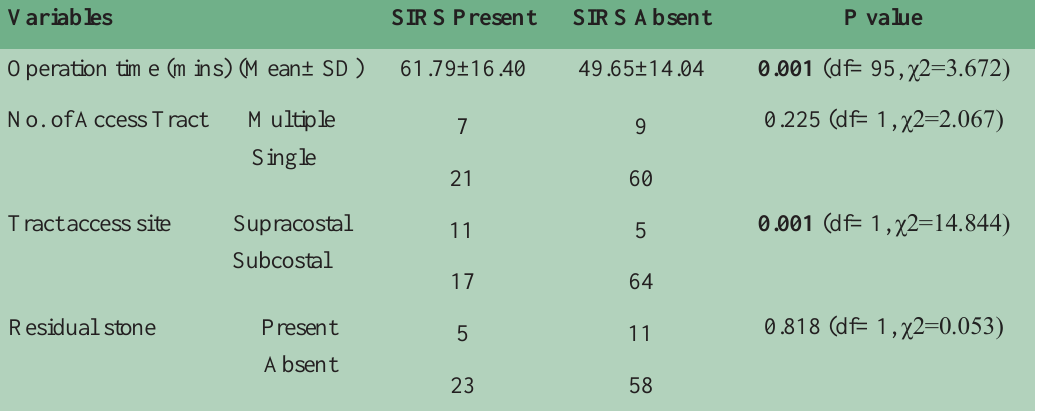
Table 2: Intra-operative parameters in relation to SIRS (N=97)